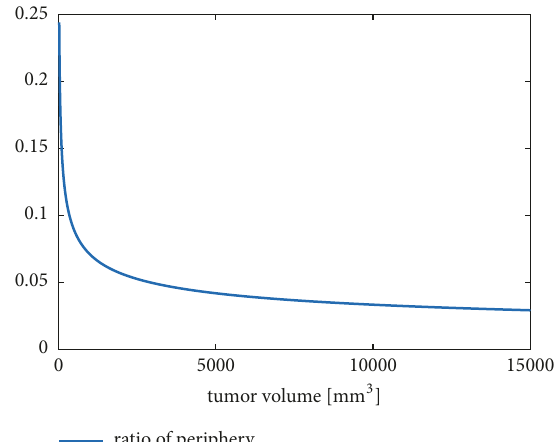
Figure 1: The function 𝑓 𝑃 (𝑉 𝑡𝑜𝑡 ) describing the ratio of periphery cells in the range of 20-15000 mm 3 tumor